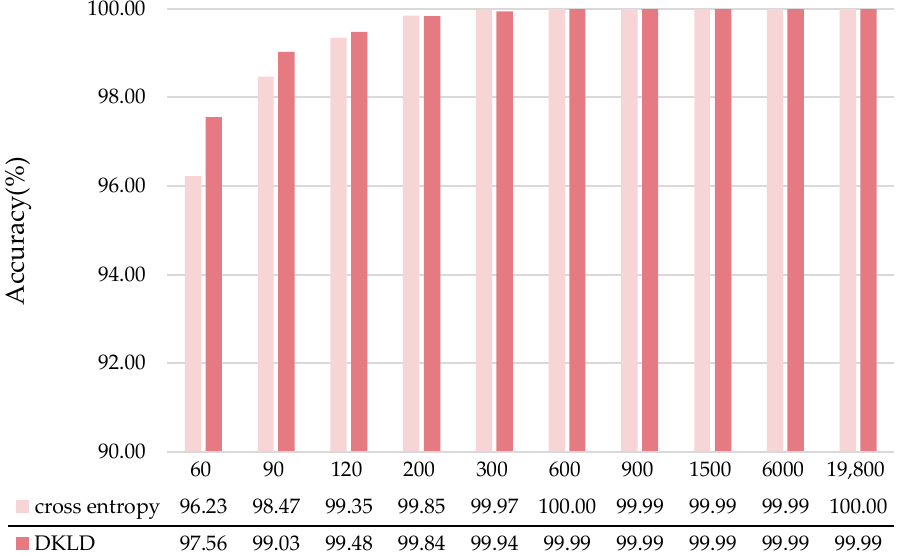
Figure 7. Results of proposed model training with different loss functions.